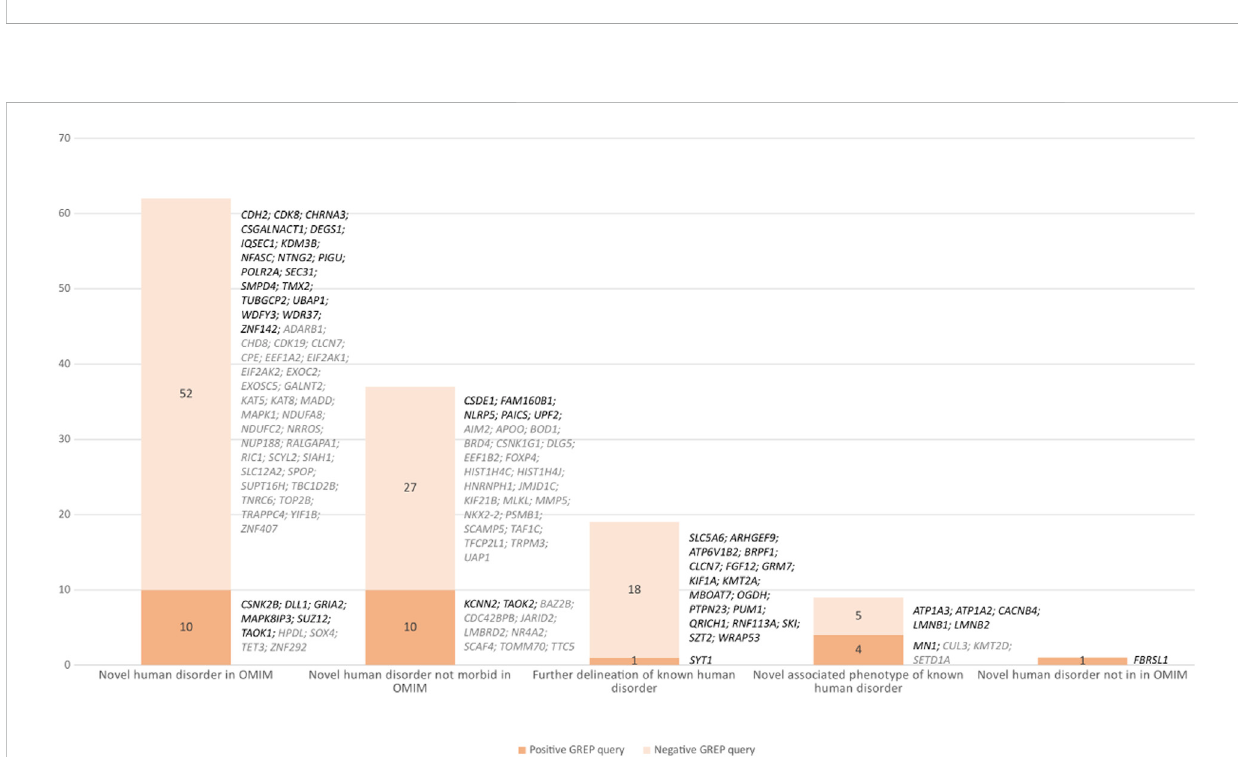
FIGURE 3 NumberofgenesresultingfrompositiveandnegativeGREPquerieswithdifferentlevelsofassociationwithhumandisorders.BlackindicatesaGREP query run in 2019 and gray a query run in 2020. Evolution of the number of exomes in the database and number of genes queried with positive and variants of unknown signi fi cance